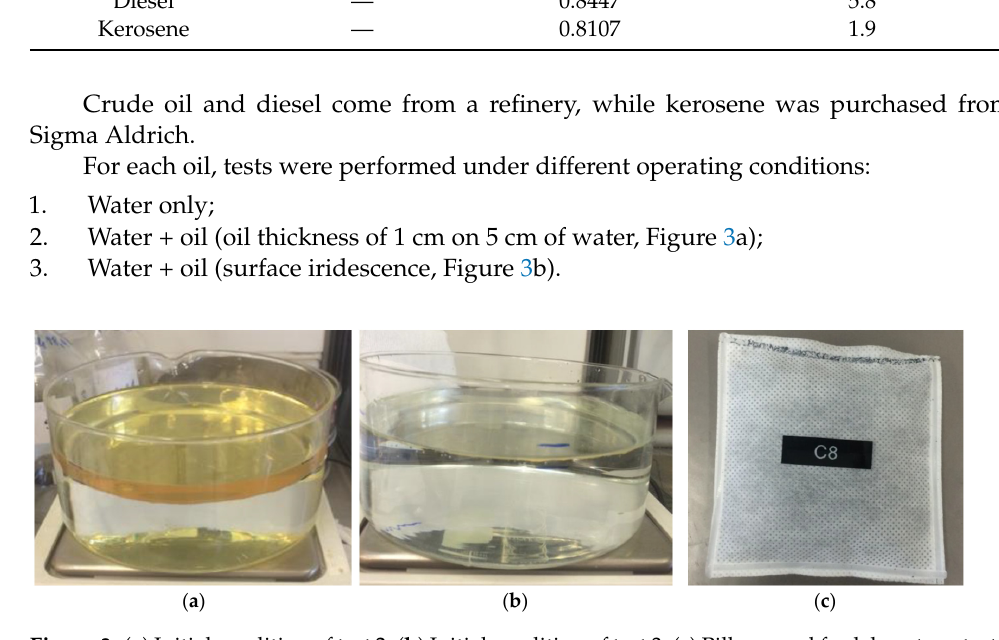
Figure 3. ( a ) Initial condition of test 2; ( b ) Initial condition of test 3; ( c ) Pillow used for laboratory